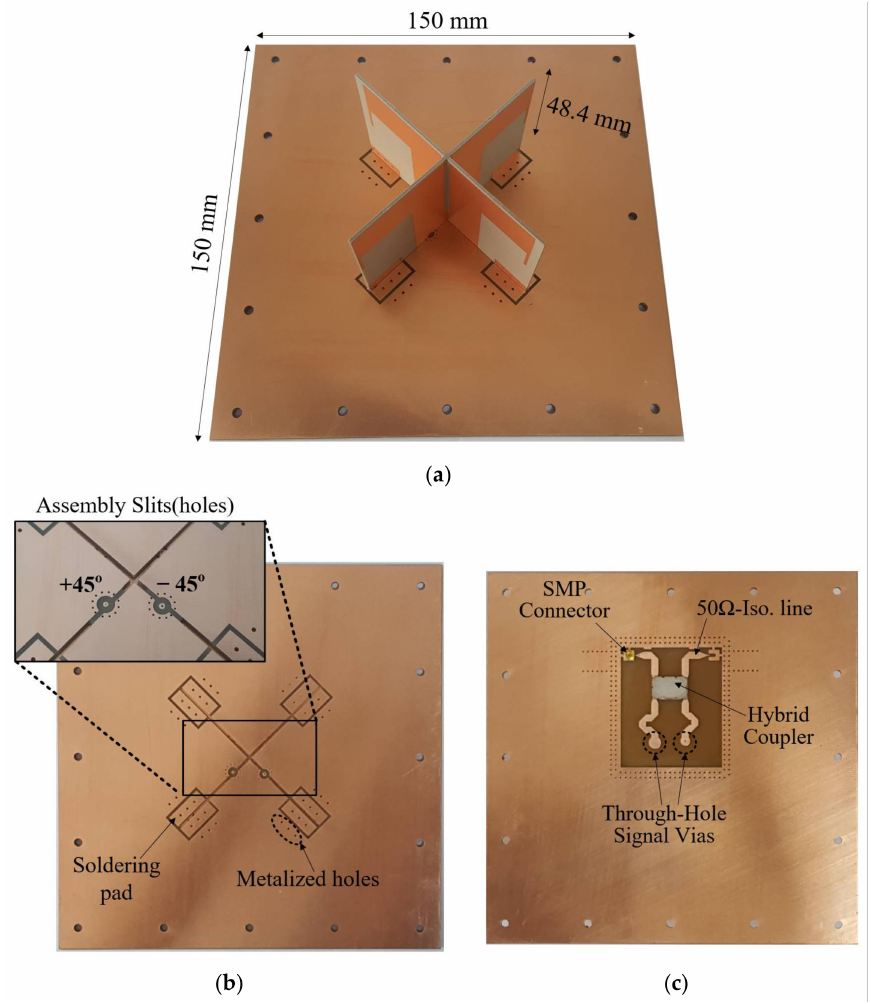
Figure 9. Photos of the fabricated antenna; ( a ) Perspective view; ( b ) Top view of the printed reflector showing the X-shaped assembly hole; ( c ) Back view of the reflector with the feed network